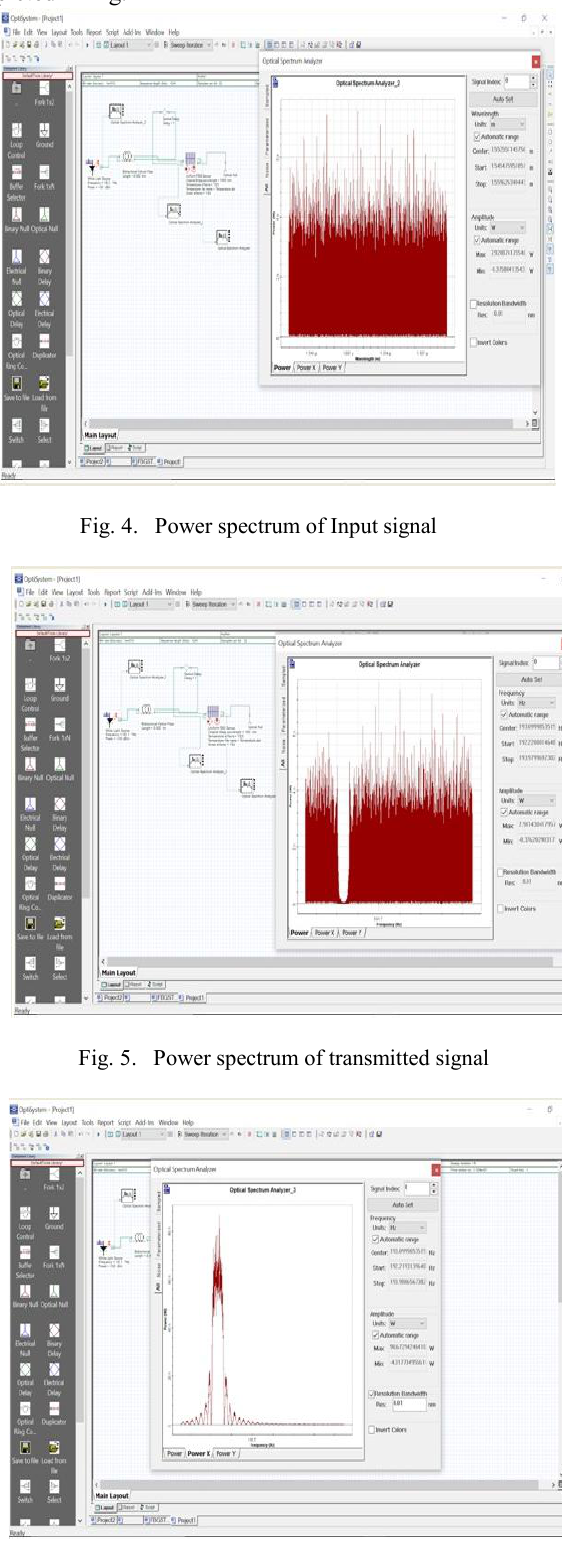
Fig. 6. Power spectrum of reflected